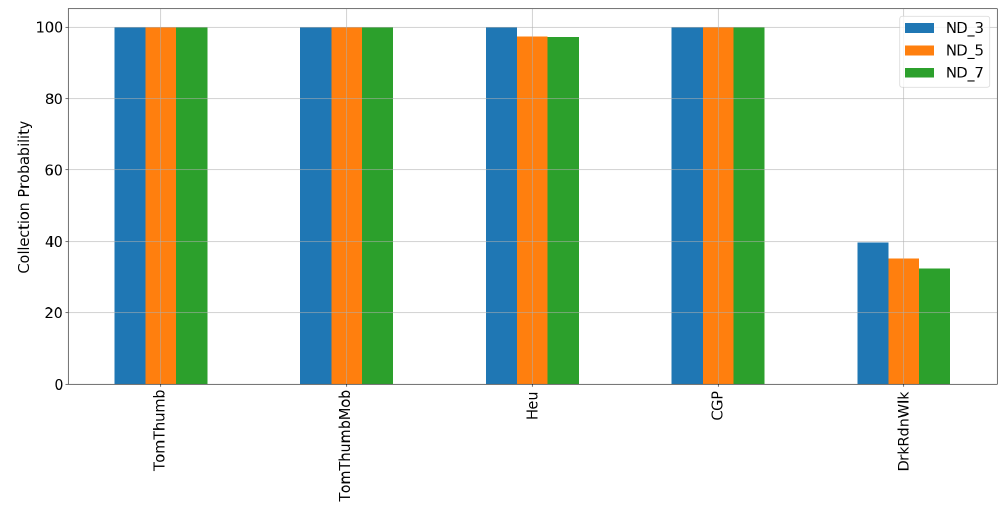
Figure 10. Collection probability comparisons among the proposed TT and alternative approaches for Scenario 2 and different ND values in the presence also of a low mobility